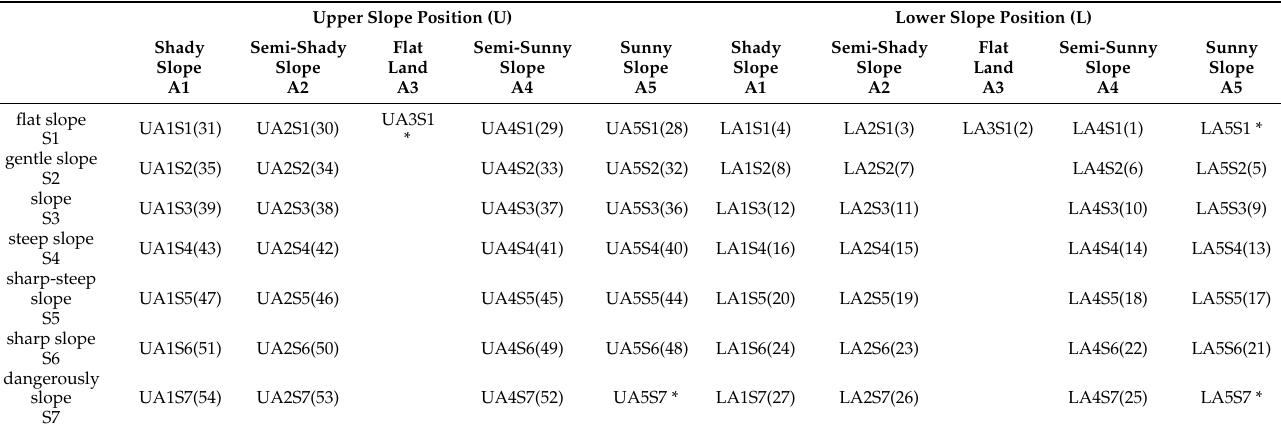
Table A1. Microtopography